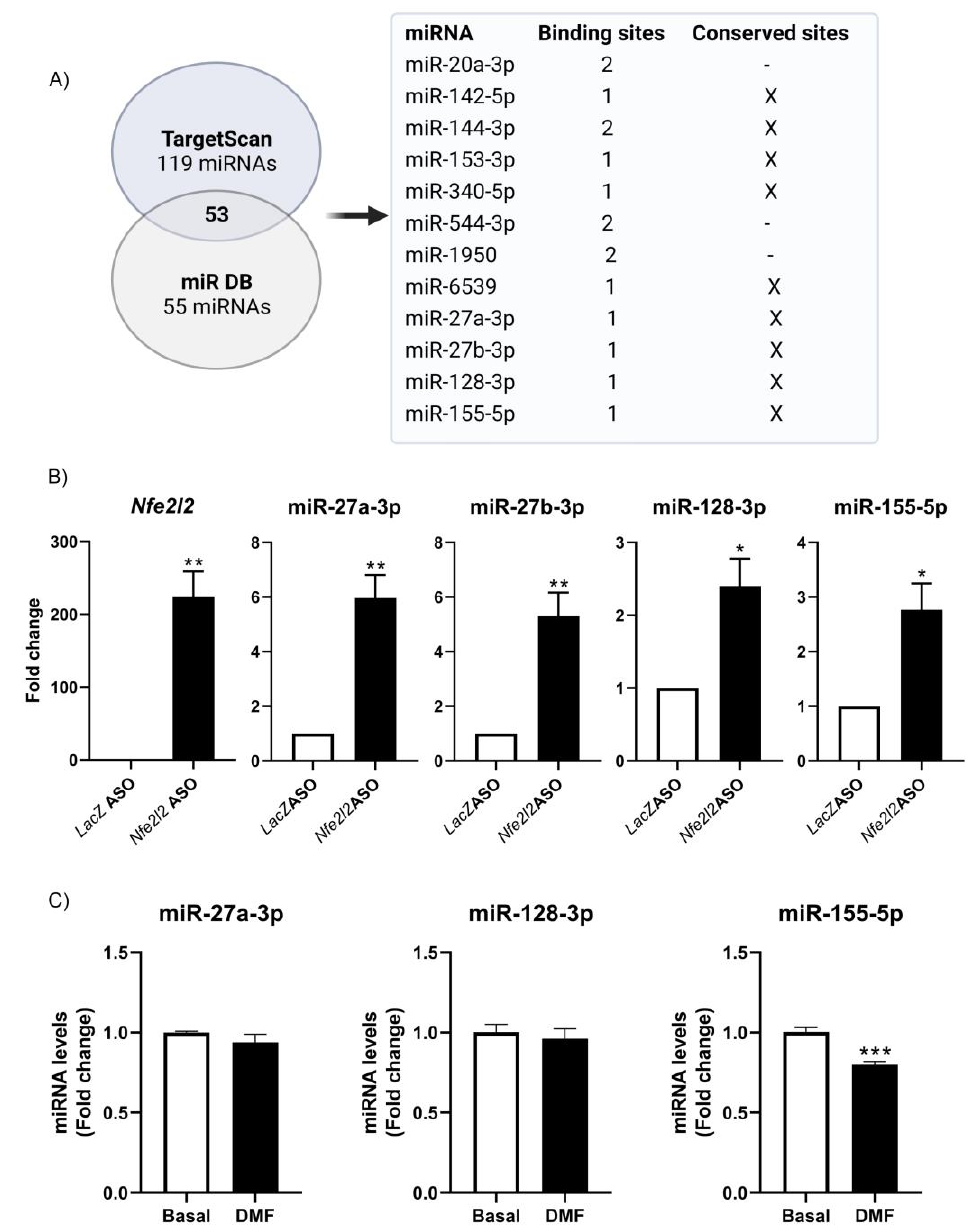
Figure 5. Association of miR-27a-3p, miR-27b-3p, miR-128-3p and miR-155-5p with Nfe2l2 mRNA and possible role of NRF2 mRNA in TDMD of miR-155-5p. ( A ) Study design. Of the 53 miRNAs common between both databases, we examined which ones contained either two binding sites or conserved sites or both. These 12 miRNAs were further analyzed. ( B ) Biotinylated antisense oligomers (ASOs) complementary to the Nfe2l2 mRNA and LacZ were incubated with HT22 lysates. After affinity pulldown using streptavidin beads, the levels of miRNA enrichment in the ASO-pulldown samples were assessed via RT-qPCR analysis, and only miR-27a-3p, miR-27b-3p, miR-128-3p, and miR-155-5p were enriched (relative to the enrichment of Gapdh mRNA, a transcript that does not bind the ASOs and encodes a housekeeping protein) in the pulldown samples. ( C ) HT22 cells were treated with DMF (20 µ M) for 16 h, and miRNA levels were measured via qPCR analysis. Asterisks denote a significant difference: * p < 0.05, ** p < 0.01, and *** p < 0.001 compared to the corresponding control group according to a Student ’ s t- test.